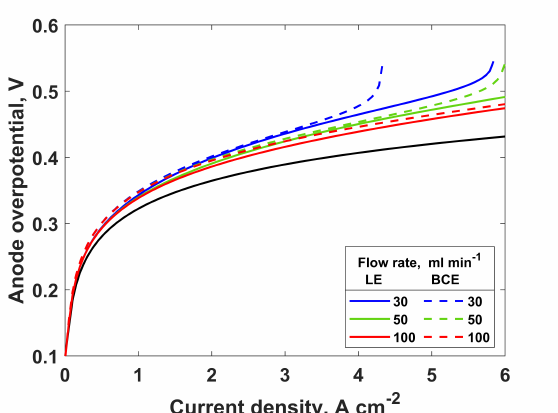
Figure 4. Anode overpotential as a function of current density for different inlet water flow rates for PTL2; solid lines—LE simulation, dashed lines—BCE simulation, black line—anode overpotential when there are no mass transport